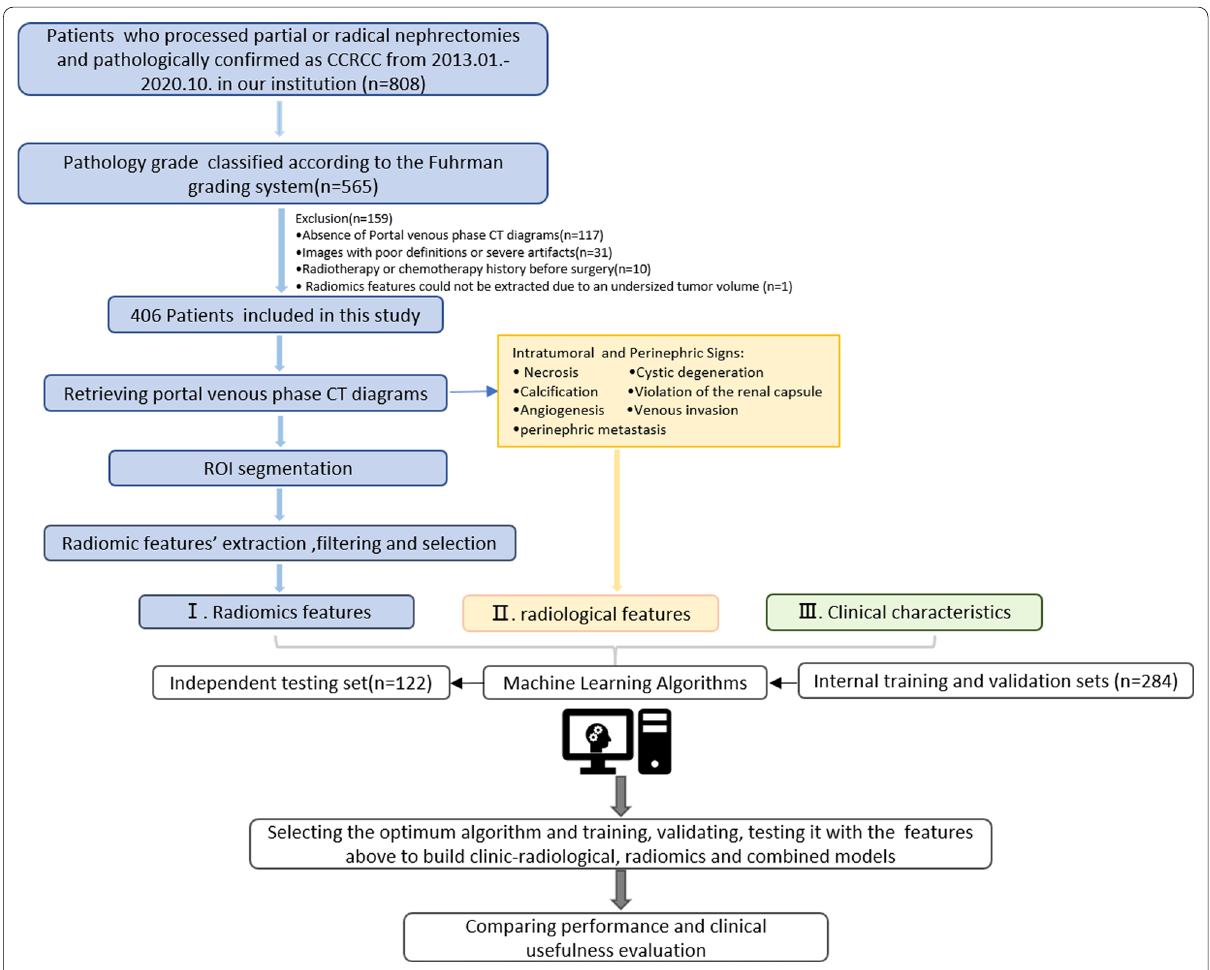
Fig. 1 Flowchart of the procedures for this study ( CCRCC clear cell renal cell carcinoma, CT computed tomography, ROI region of